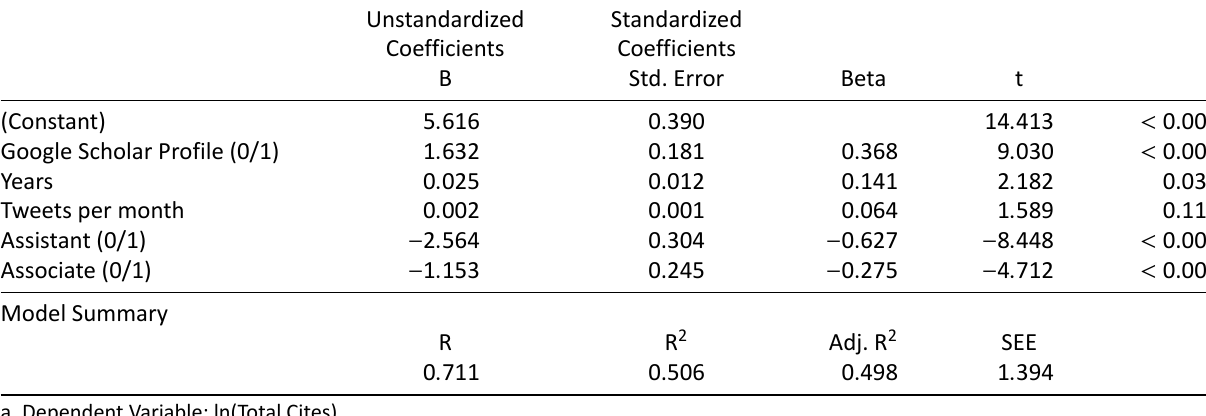
Table 3. Regression